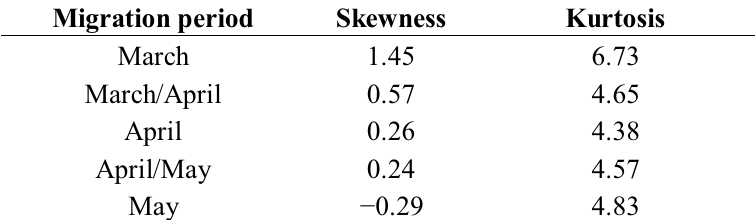
Table 3. The relationship of migration period on skewness and kurtosis. Means are provided. Migration period had significant effects on both measurements in Kruskal-Wallis rank